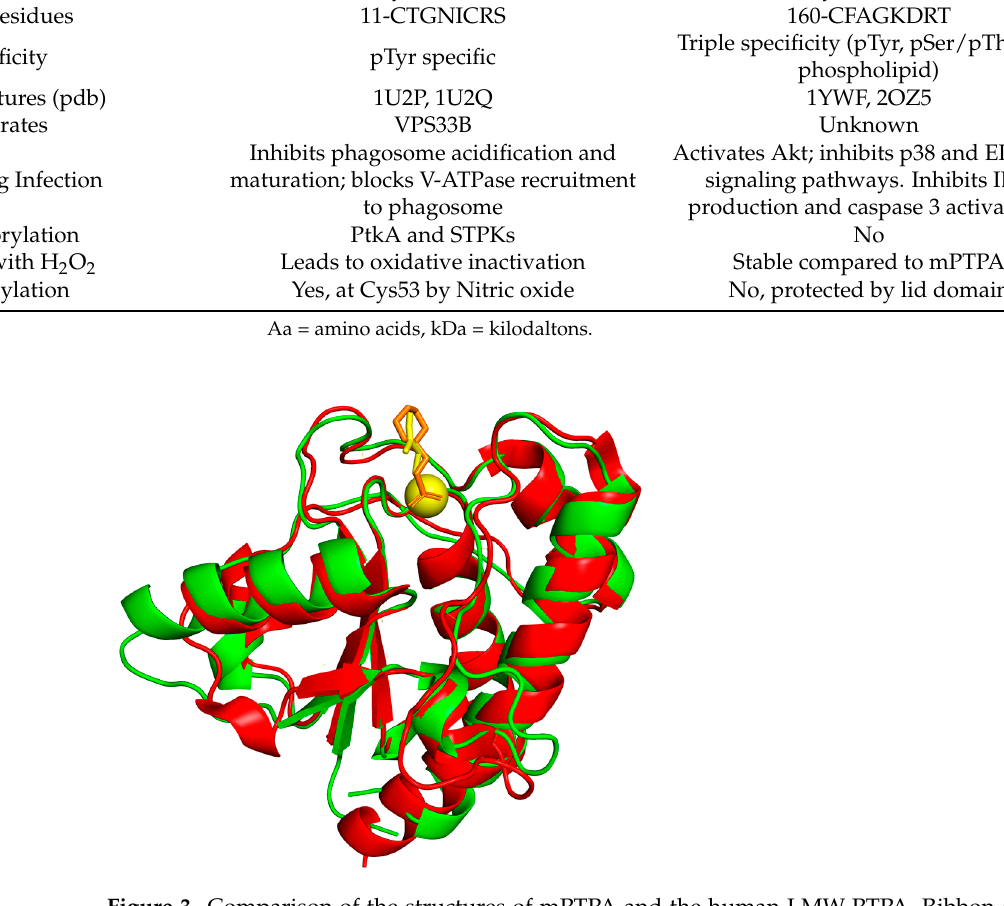
Figure 3. Comparison of the structures of mPTPA and the human LMW ‐ PTPA. Ribbon diagram showing the superposition of mPTPA (red, PDB code: 1U2Q) and the human LMW ‐ PTPA (green, PDB code: 5PNT). Chloride ion and glycerol molecule (shown in yellow) are shown in the active site of mPTPA, and the 2 ‐ (N ‐ morpholino) ‐ ethanesulfonic acid molecule (shown in orange) in the human LMW ‐ PTPA.